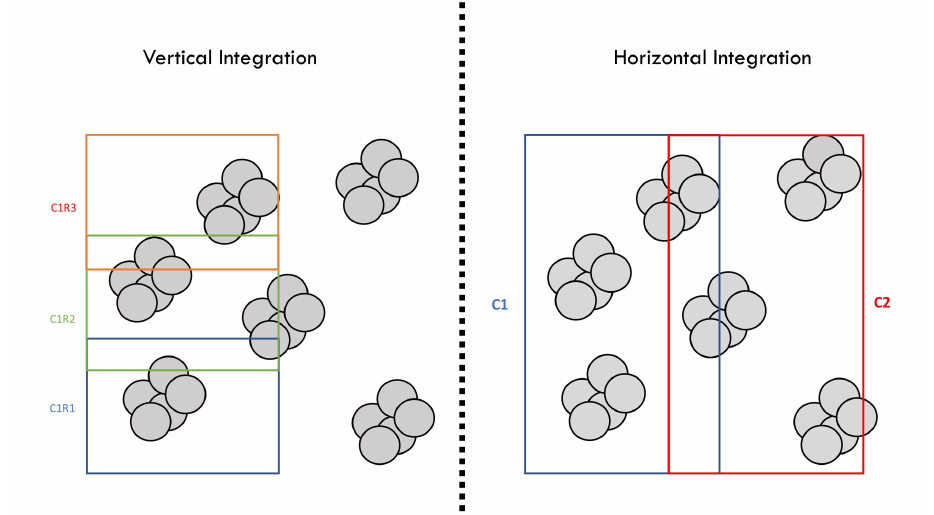
Figure 4. Illustration of the vertical and horizontal registration necessary to integrate across